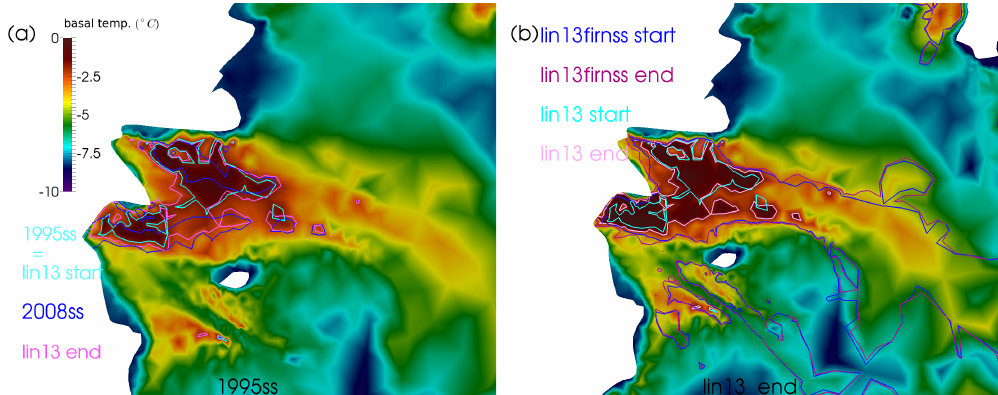
Figure 11. In a close-up of the Franklinbreen area the change in the extent of the “sliding area” (basal temperatures above 271K) is shown. In (a) the texture is the 1995ss temperature distribution (temperatures relative to pressure melting). The light blue corresponds to the extent of the “sliding area” for 1995ss , dark blue for 2008ss and pink for the end of lin13 . In (b) the temperature at the end of the 13yr simulation when neglecting firn heating ( lin13 ) (temperatures relative to pressure melting) is used as texture – same colour scale as (a) . The light colours present the “sliding area” when neglecting firn heating ( lin13 ), dark colours when including it ( lin13firnss ); blue lines represent the start of the 13yr simulation and pink the